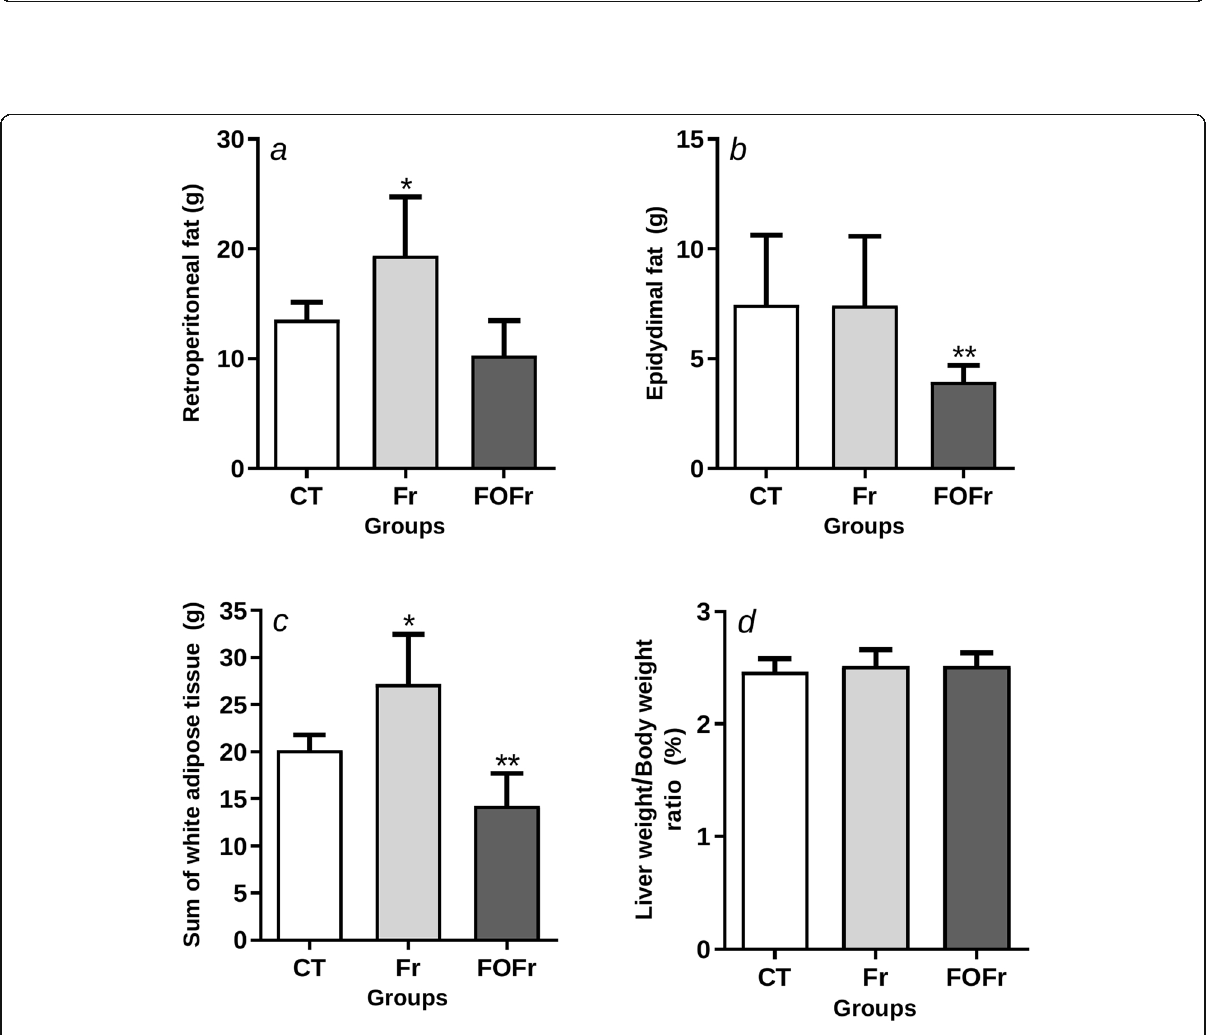
Fig. 2 Body composition. a Retroperitoneal fat, b epididymal fat, c sum of adipose tissues, and d liver weight corrected by animal weight. Values are mean ± SD. Asterisk indicates a significant difference when compared to CT and FOFr. Double asterisk indicates a significant difference when compared to CT and Fr ( P <